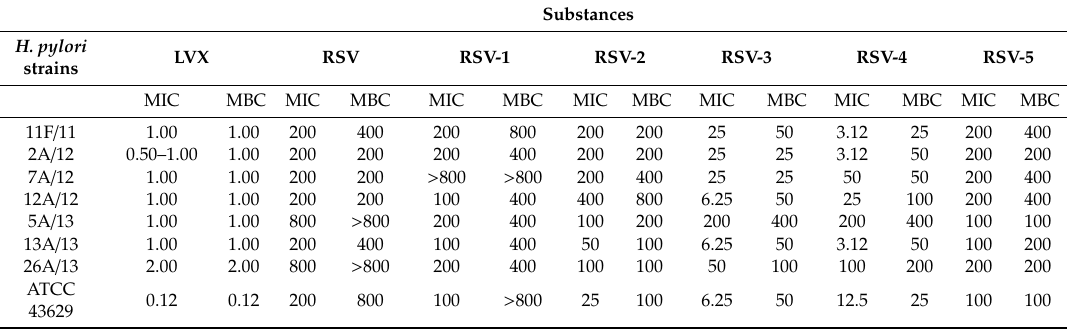
Table 1. Minimum Inhibitory Concentration (MIC, µ g / mL) and Minimum Bactericidal